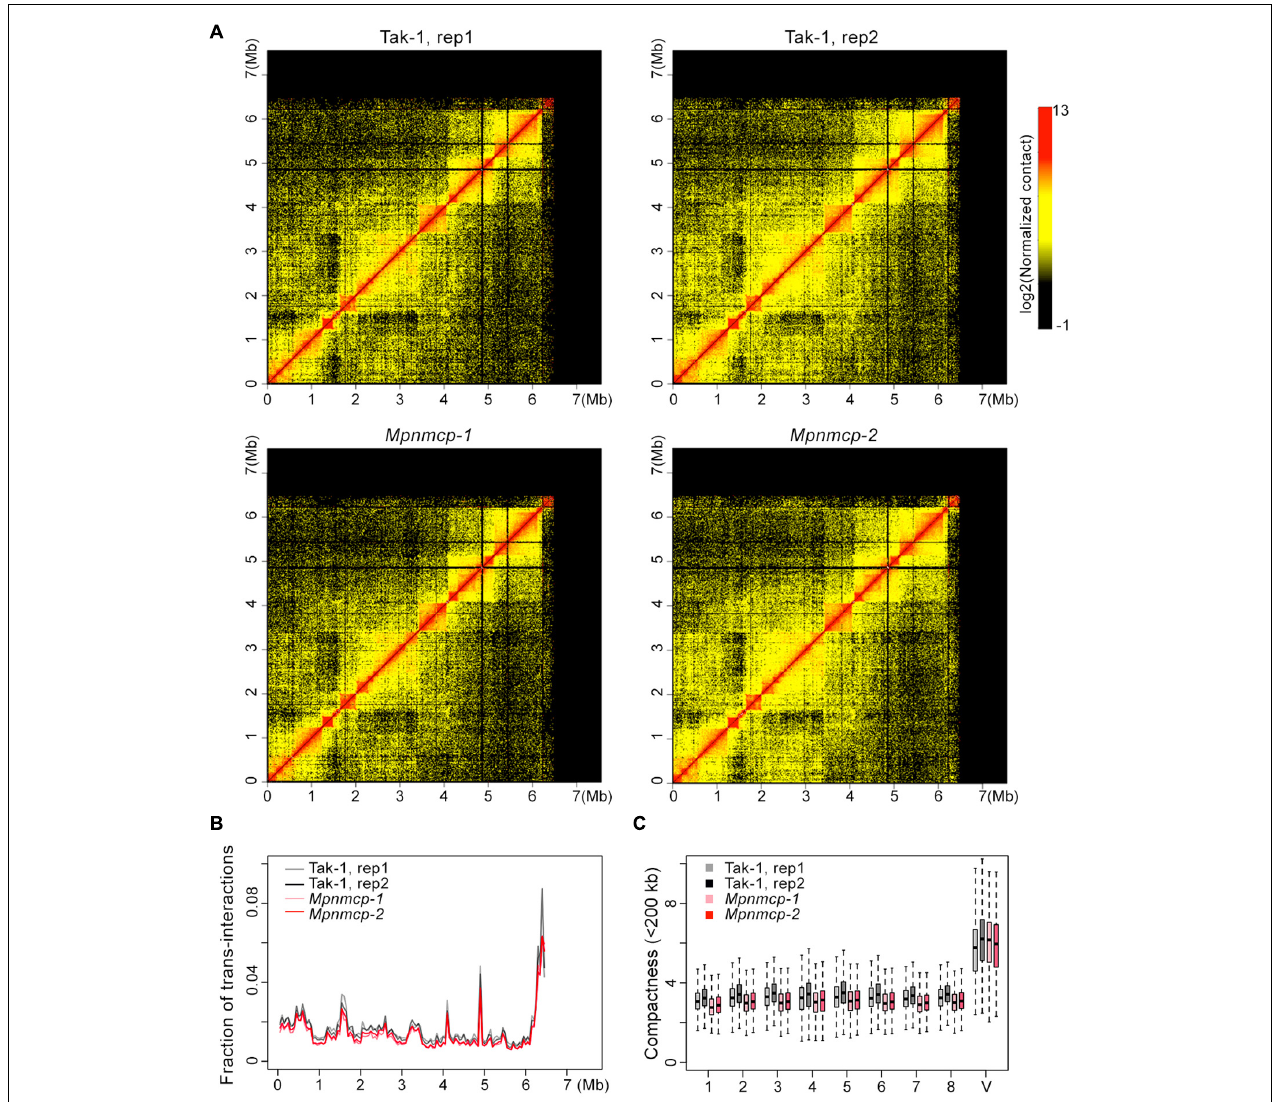
FIGURE 6 | Comparison of the V chromosome organization patterns in wild-type (WT) Tak-1 and Mpnmcp . (A) Hi-C maps of the V chromosome normalized at 10-kb resolution. (B) Inter-chromosomal interaction patterns across the V chromosome. (C) Comparison of chromatin compactness of individual chromosomes derived from Hi-C